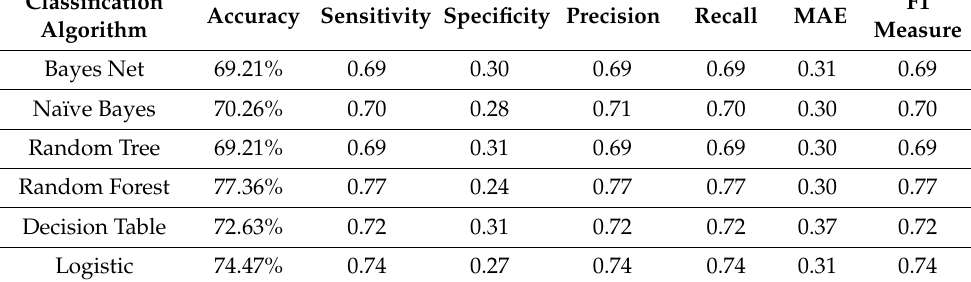
Table 11. GLCM results on